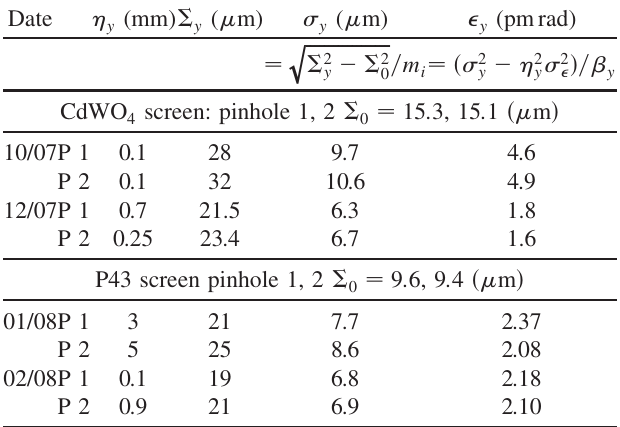
TABLE III. Vertical emittance measurements. Horizontal emittance and relative energy spread are measured close to the nominal values, i.e., 2.7 nm rad and 0.001, respectively. The betatron values are (cid:11) y; 1 ¼ 21 : 54 m and (cid:11) y; 2 ¼ 23 : 38 m . The magnification is m 1 ; 2 ¼ 2 : 4 ; 2 : 7 for pinhole 1 and pinhole 2, respectively. (cid:7) i and (cid:1) i are measured values, and P stands for pinhole.